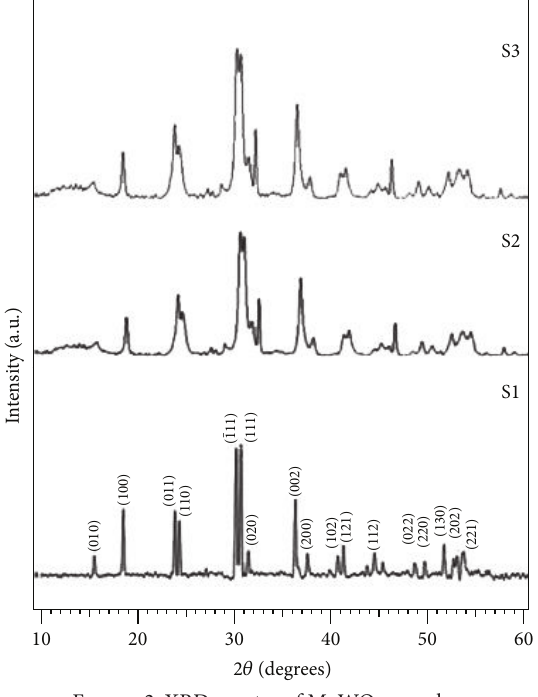
Figure 2: XRD spectra of MnWO 4